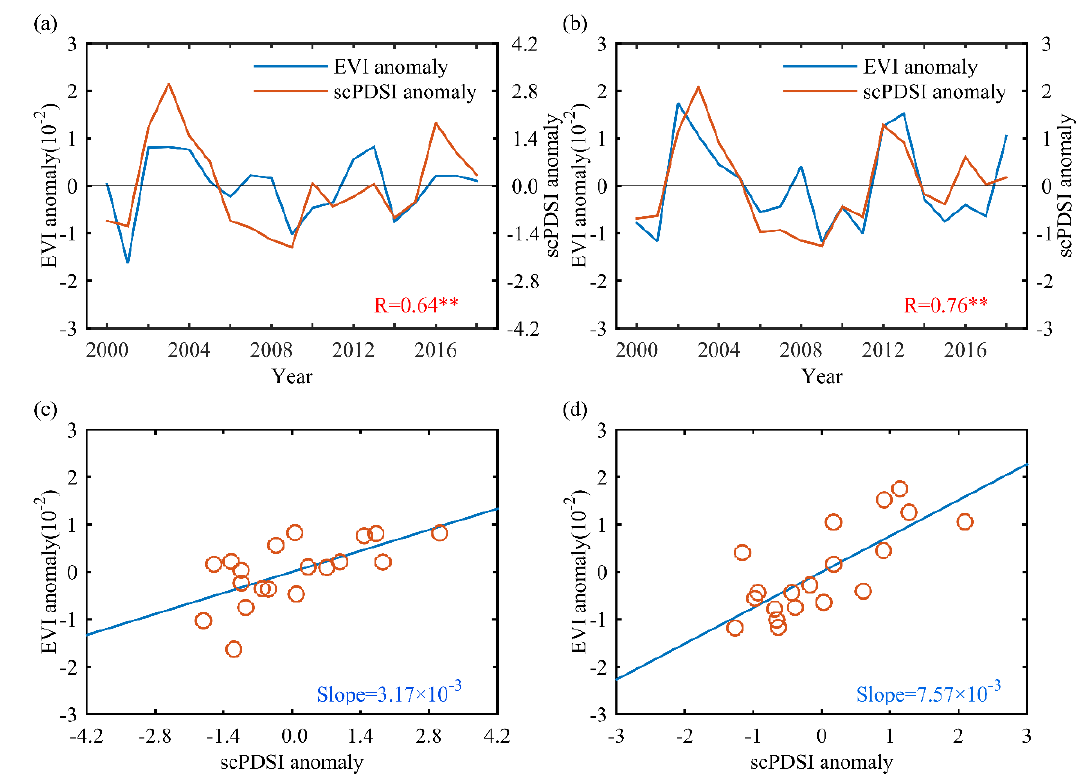
Figure 7. Correlation coefficients and linear fitting slopes between scPDSI anomalies and EVI anomalies of farmland ecosystems during the growing season in the DNC from 2000 to 2018: ( a ) correlation in arid drylands, ( b ) correlation in semi-arid drylands, ( c ) linear fitting slopes in arid drylands, and ( d ) linear fitting slopes in semi-arid drylands. (** indicates statistical significance at 0.05 level.).